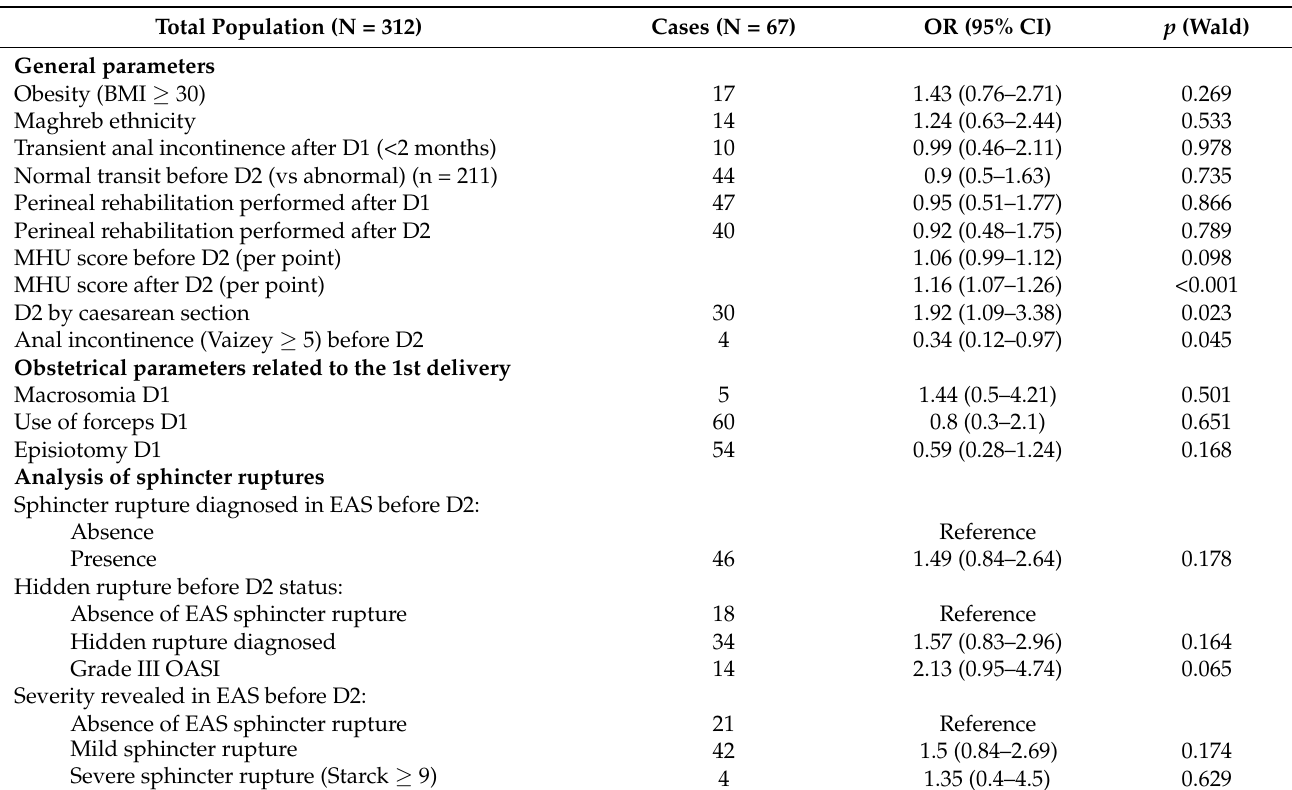
Table 4. Factors associated with a worsening of the Vaizey score ≥ 2 points after second delivery (Univariate analysis).